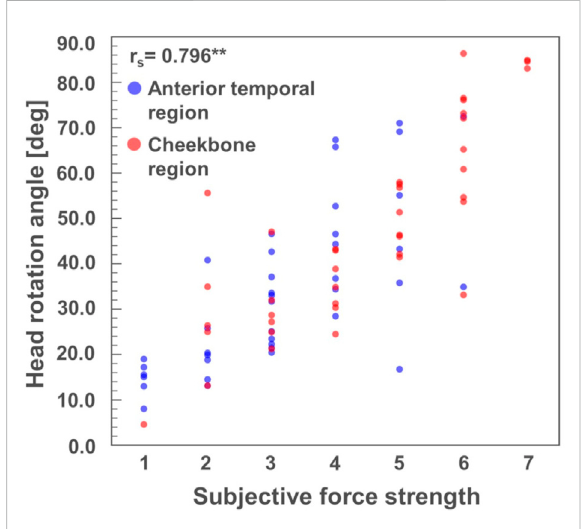
FIGURE 7 Relationship between head rotation angle and subjective force strength (**: p < 0.01).